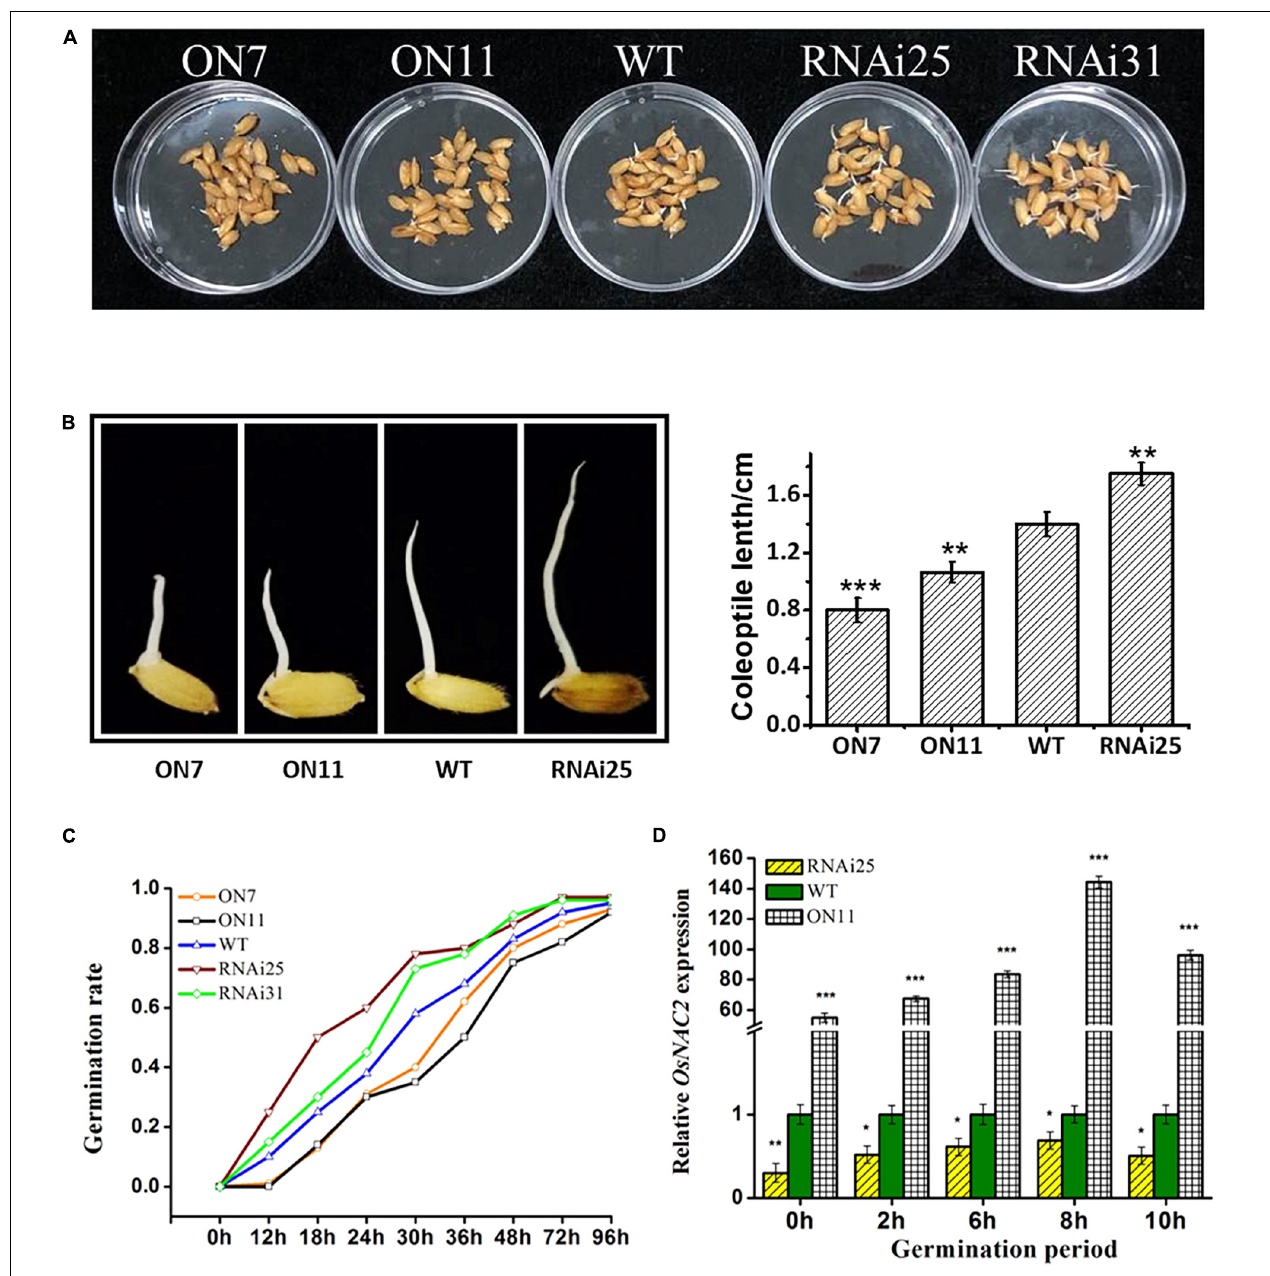
FIGURE 3 | Effects of OsNAC2 on the germination of seeds and coleoptile of OsNAC2 -transgenic plants. (A) Germination phenotype of wild-type (WT) and OsNAC2 -transgenic seeds under normal conditions of germination. (B) Coleoptile length of WT and OsNAC2- transgenic seeds. The experiment was conducted at least three times, with 50 seeds in each Petri dish. (C) The germination rate of WT and OsNAC2- transgenic seeds. The experiment was conducted at least three times, with 50 seeds in each Petri dish. (D) Expression pattern of OsNAC2 during the germination period in the WT, OsNAC2-overexpressing (ON11), and OsNAC2-knockdown (RNAi25) transgenic seeds. Data are presented as the mean ± standard error of at least three biological replicates. Asterisks indicate significant differences between treatment and control by t -test. * p < 0.05, ** p < 0.01, and *** p <